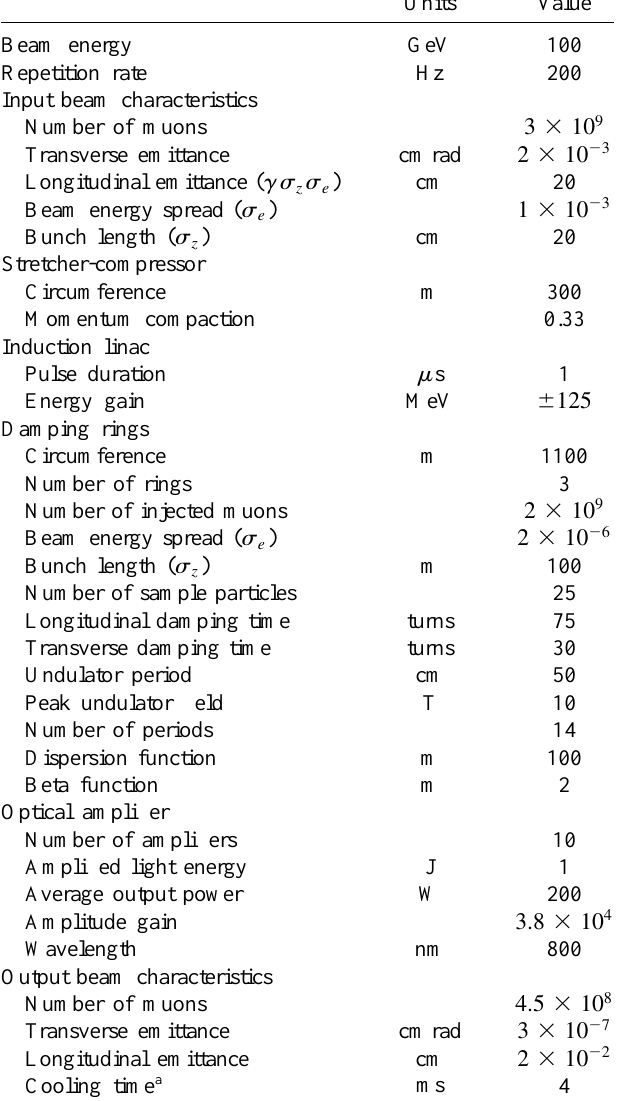
TABLE I. List of the beam parameters and parameters of the cooling